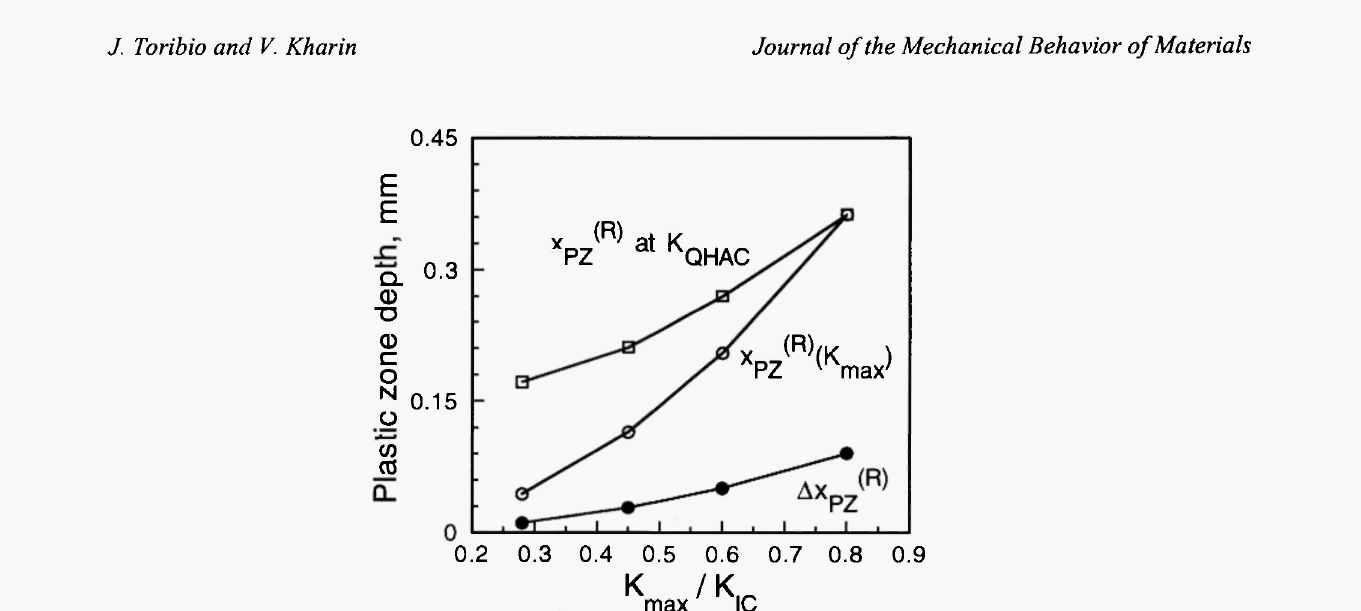
Fig. 8: Plastic zone sizes theoretically predicted according to the model proposed by Rice /8/: during fatigue pre-cracking (monotonic for K=K the end of the HAC tests (i.e., at Κ = Kqhac)·